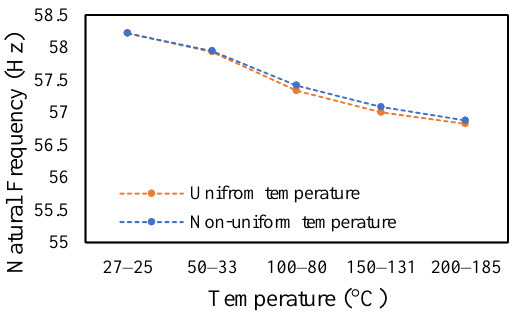
Figure 18. Modal amplitude of 1 mm crack depth in non-uniform temperature.